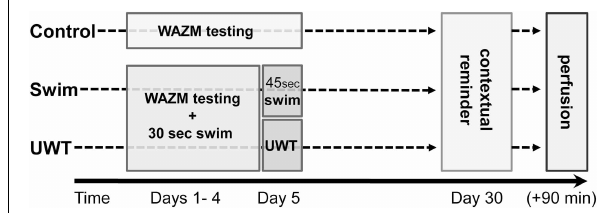
FIGURE 2 | Experimental design. UWT and Swim rats were exposed to 4 consecutive days of testing in the WAZM immediately followed by a 30s swim session. On the 5th day, UWT rats were exposed to the WAZM testing immediately followed by the underwater trauma stress. Swim rats were exposed to the WAZM testing immediately followed by 45s swim. On the 30th day all rats were exposed to the WAZM testing as a contextual